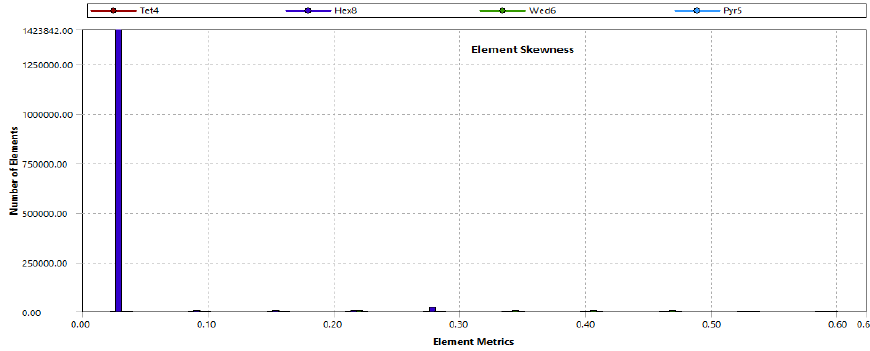
Figure 5. Skewness of the elements.